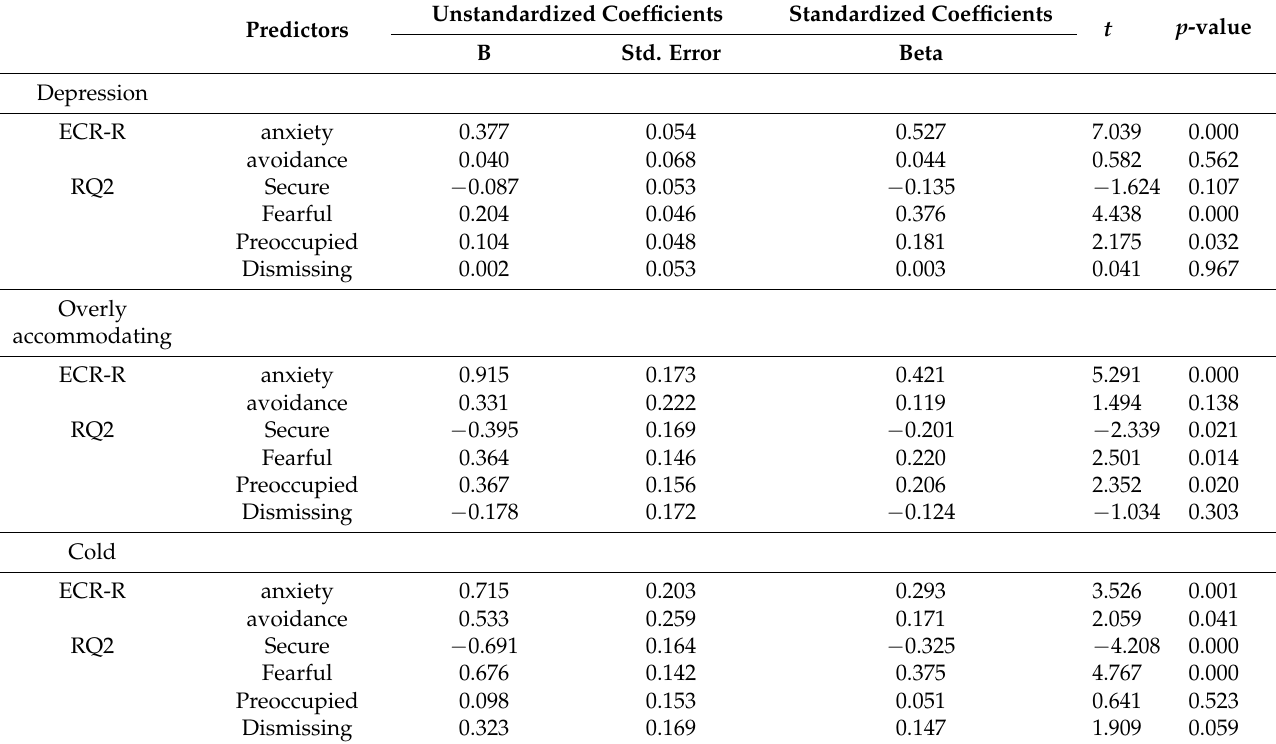
Table 6. Predictions for depression and interpersonal